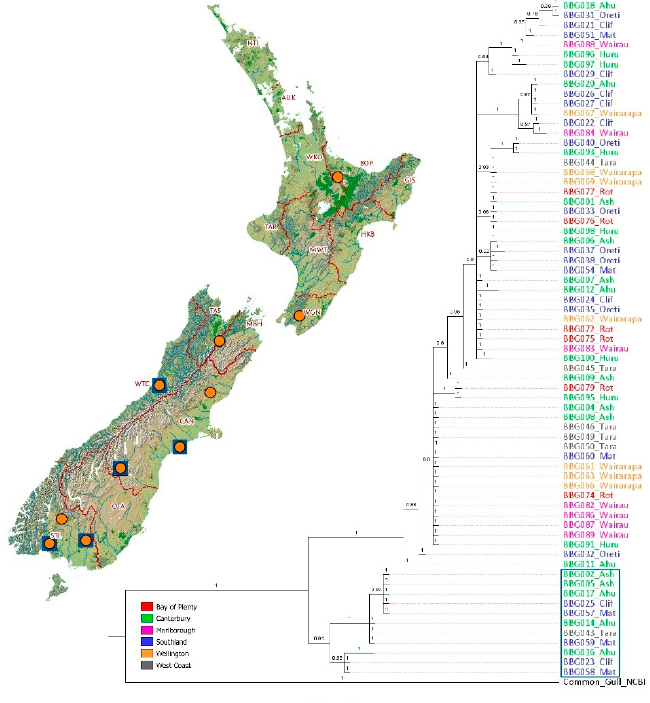
Figure 1 . Bayesian tree of black-billed gulls using mtDNA (mitochondrial DNA) control region, first domain. Posterior probabilities are shown above the branches. Scale depicts the distance corresponding to 0.005 nucleotide substitutions per site. Orange circles show locations of colonies from which chick blood samples were analysed (10 colonies, 100 samples; 94 for Single Nucleotide Polymorphisms (SNPs), 69 for mtDNA control region). Blue rectangle on the tree contains locations corresponding to the blue squares on the inset map highlighting the locations of colonies found within the smaller clade (matching published red-billed gull data). Colour legend indicated regions. Regions are outlined: AUCK—Auckland, BOP—